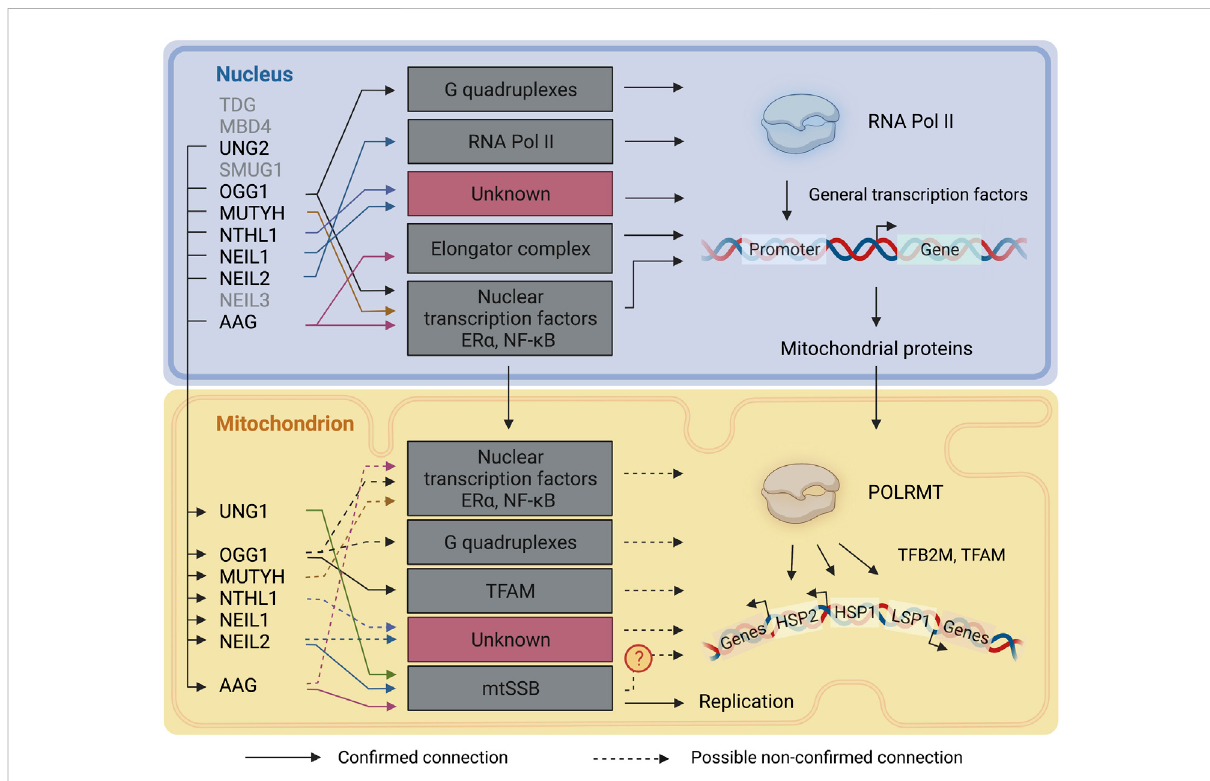
FIGURE 4 DNA glycosylases involvement in transcriptional regulation. A representation of the connections between DNA glycosylases and the transcription mechanisms in the nucleus and mitochondria. Continuous lines represent connections that have been described. Dashed lines represent connections that are likely to take place but have not been directly described. TDG: Thymine-DNA glycosylase; MBD4: Methyl-CpG- domain protein 4; UNG1/2: Uracil-DNA glycosylase; SMUG1: Single-strand selective monofunctional uracil DNA glycosylase 1; OGG1:8- Oxoguanine-DNA glycosylase 1; MUTYH: Adenine-DNA glycosylase; NTHL1: Endonuclease III-like protein 1; NEIL1: Nei endonuclease VIII-like 1; NEIL2: Nei endonuclease VIII-like 2; NEIL3: Nei endonuclease VIII-like 3; AAG: Alkyladenine-DNA glycosylase. RNA Pol II: RNA polymerase